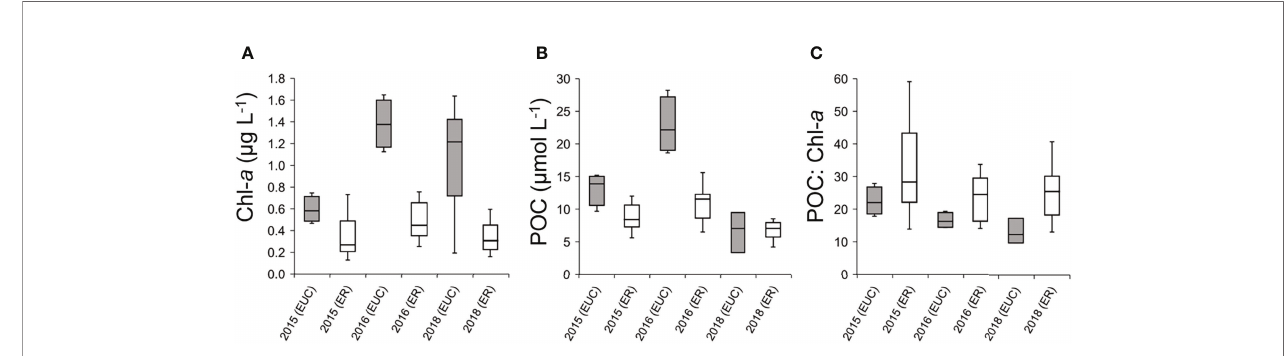
FIGURE 8 | Comparison of oceanographic variables in the Equatorial undercurrent upwelling (EUC) and eastern (ER) regions between this study and measurements collected previously during the same season; 2015 sampling was during an El Niño event whereas 2016 and 2018 were during neutral conditions. (A) Interquartile range of Chlorophyll- a concentrations (Chl- a , m g L -1 ). (B) Interquartile range of particulate organic carbon (POC, m mol L -1 ) concentrations. (C) Interquartile range of POC to Chl-